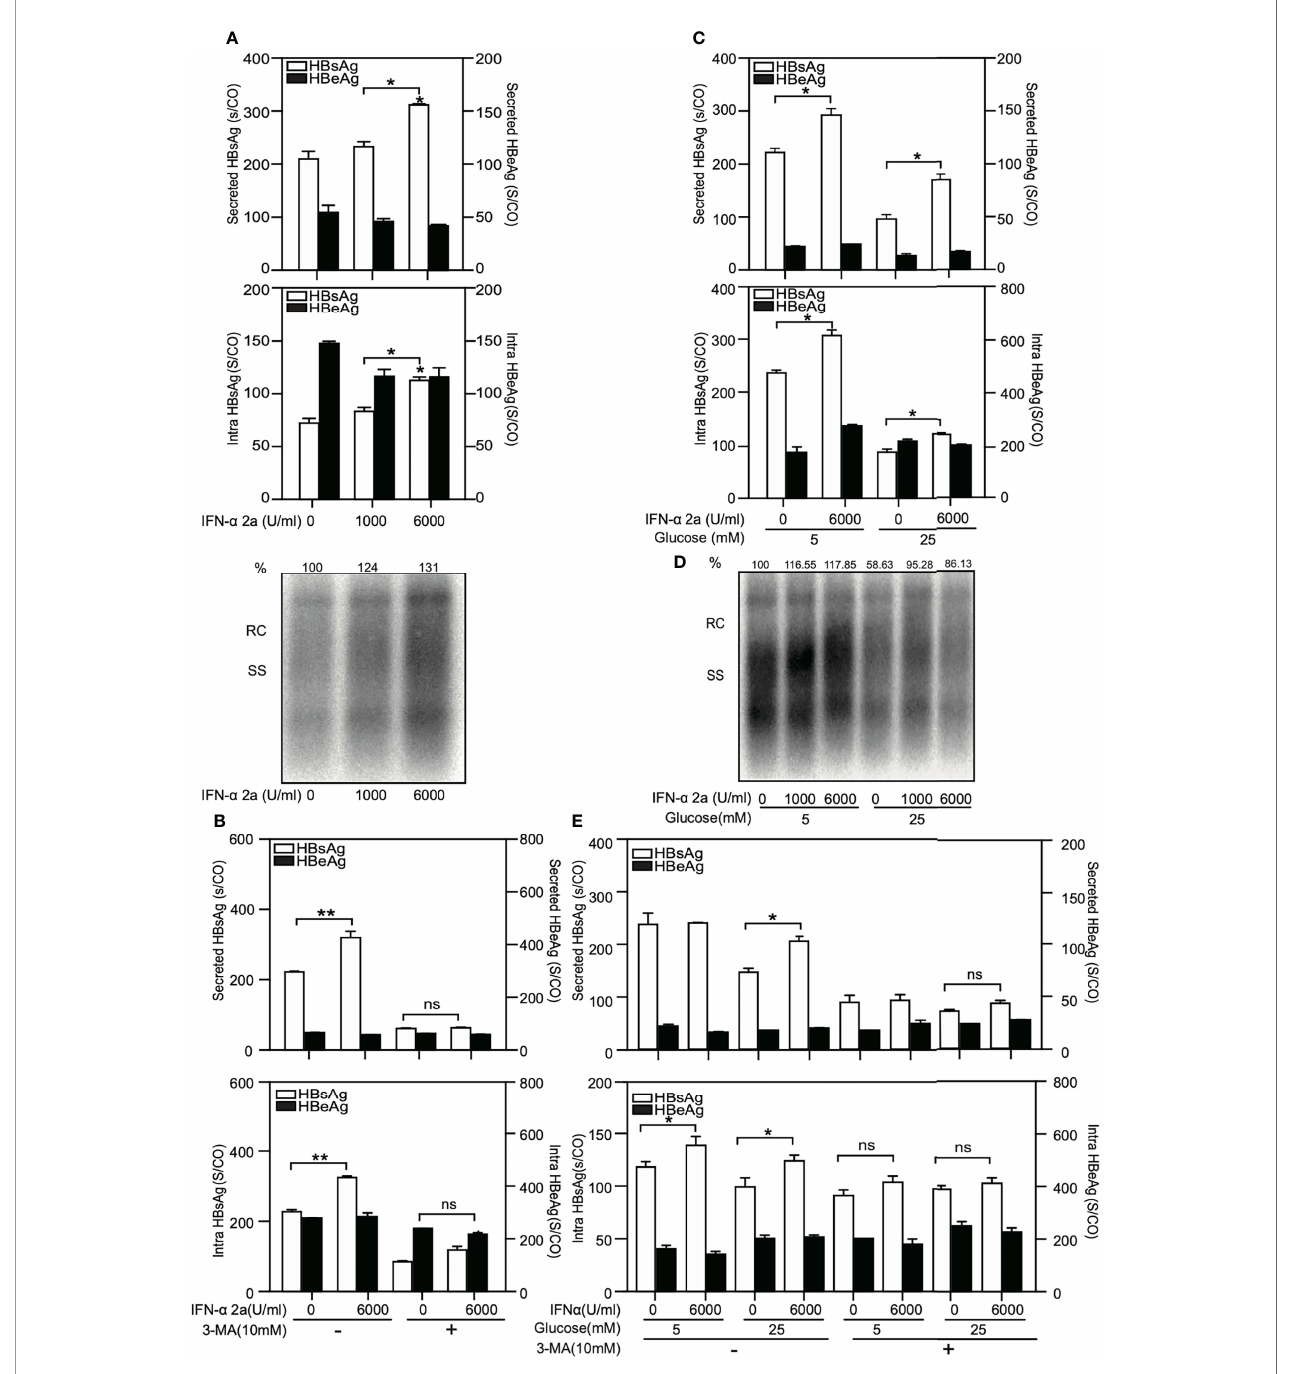
FIGURE 6 | High IFN a -2a concentrations do not inhibit HBV replication and gene expression in HepG2.2.15 cells. (A) HepG2.2.15 cells were cultured in medium with the indicated concentrations of IFN a -2a. (B) HepG2.2.15 cells were treated with 6000 U/ml IFN a -2a with or without 10 nM 3-MA. (C) HepG2.2.15 cells were cultured in medium with the indicated glucose concentrations (5 and 25 mM) and treated with 6000 U/ml IFN a -2a. After 72 hr, cells were harvested and the HBsAg and HBeAg levels in the culture supernatants and intracellular HBsAg and HBeAg from cell lysates were quanti fi ed by chemiluminescent microparticle immunoassay Å(CMIA). (D) HepG2.2.15 cells were cultured at the indicated glucose concentrations (5 and 25 mM) and IFN a -2a (1000 U/ml and 6000 U/ml). Encapsidated HBV RIs were detected by Southern blotting. (E) HepG2.2.15 cells were cultured at the indicated glucose concentrations (5 and 25 mM) and 6000 U/ml IFN a -2a with or without 10 nM 3-MA. After 72 hr, cells were harvested and the HBsAg and HBeAg levels in the culture supernatants and intracellular HBsAg and HBeAg from cell lysates were quanti fi ed by chemiluminescent microparticle immunoassay (CMIA). *P < 0.05; **P < 0.01; ns, not signi fi cant; RC, relaxed circular DNA; S/CO, signal to cutoff ratio; SS, single ‐ stranded